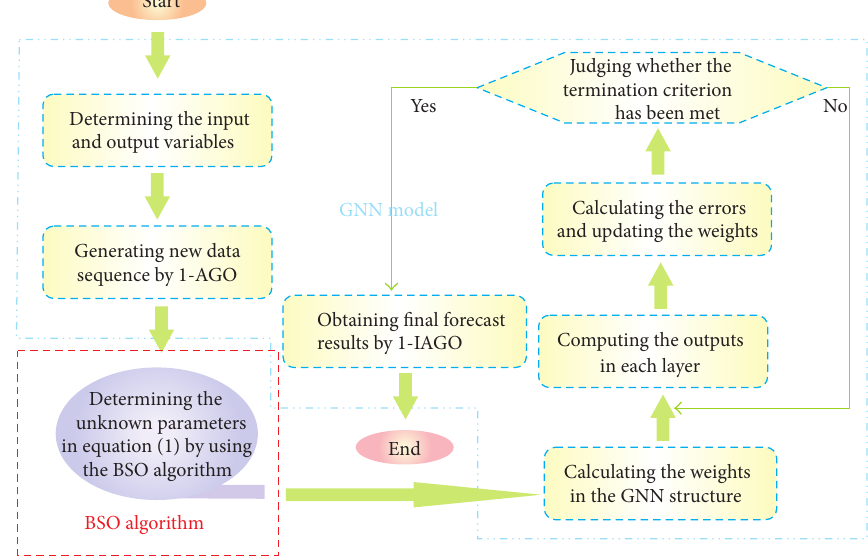
Figure 2: Flowchart of the new proposed BSO-GNN